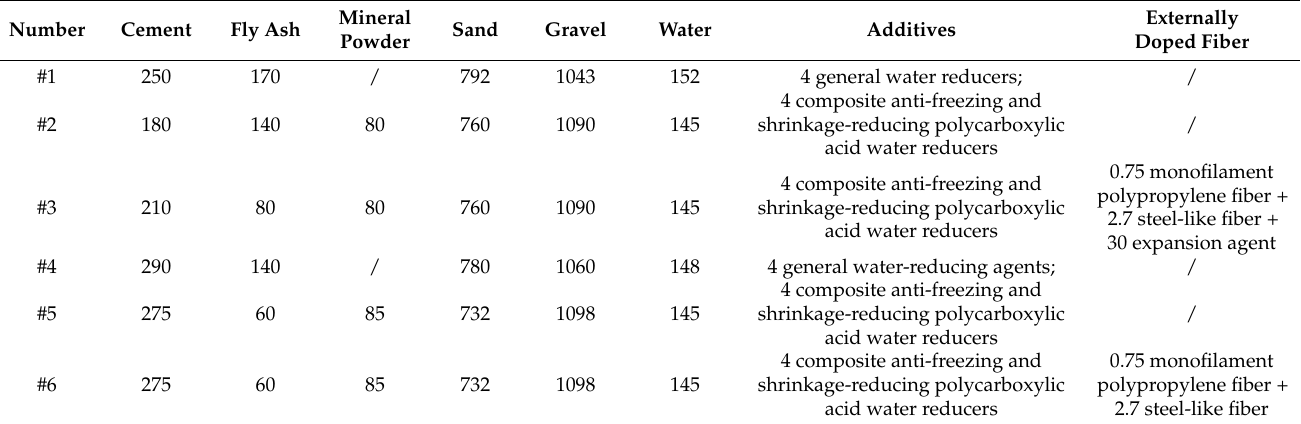
Figure 1. Steel-like fiber. Table 1. Baseline concrete mix ratios for different strength classes and parts (kg/m 3 ).